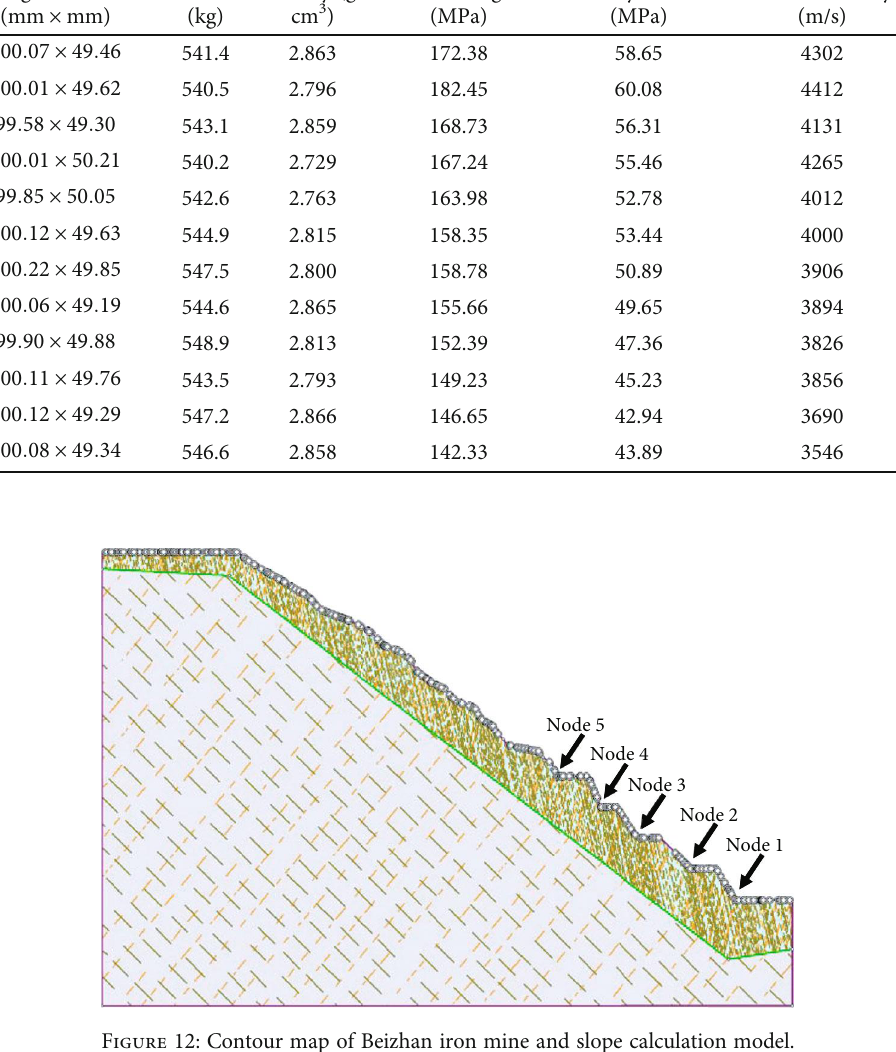
Table 3: Basic mechanical and physical parameters of freeze-thaw-treated granite samples.